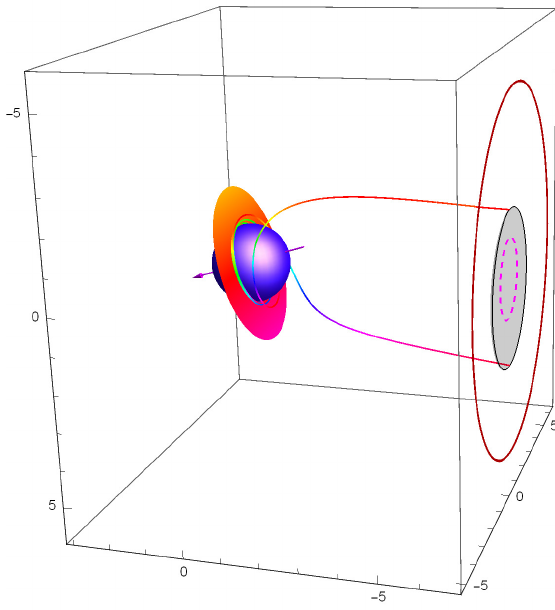
Figure 9. Two 3D photon trajectories, starting from the di ff erent points of the circle with a radius r = 1.01 r h at the thin accretion disk (orange oval) in the equatorial plane of rotating black hole with the spin a = 0.9982 and reaching a distant observer near the outer contour of the event horizon silhouette (dark gray region). The closed dark red curve is a projection of the classical black hole shadow contour on the celestial